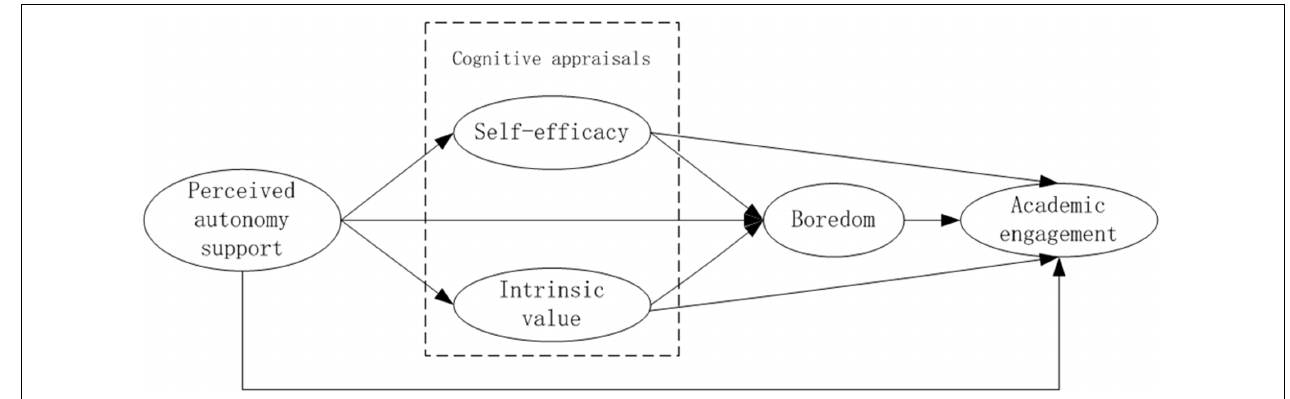
FIGURE 1 | The overall hypothesized model of relations among study